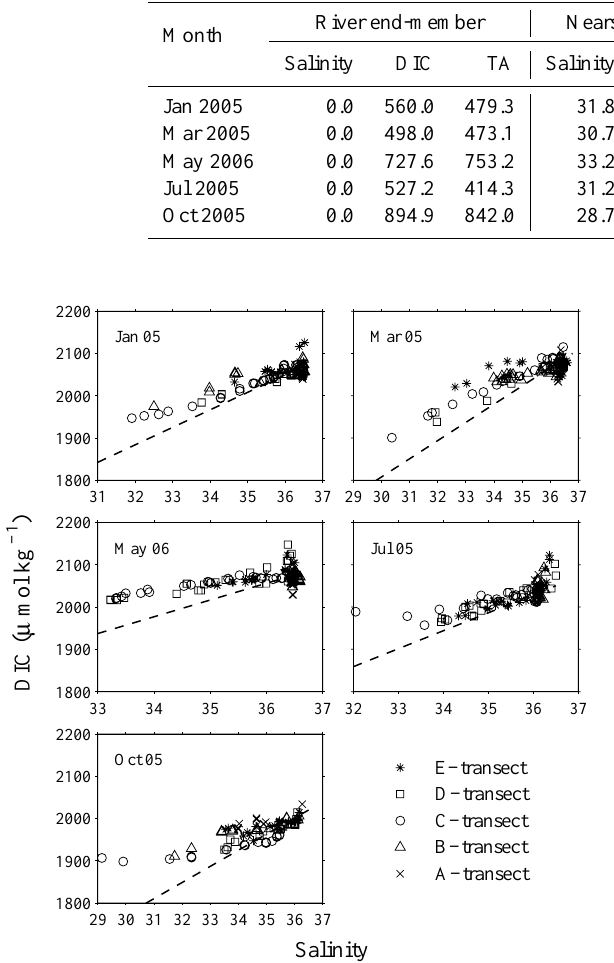
Fig. 3. Dissolved inorganic carbon (DIC) concentrations at depths shallower than 100m vs. salinity and grouped by sampling month. The dotted lines connect the river and ocean end-members.